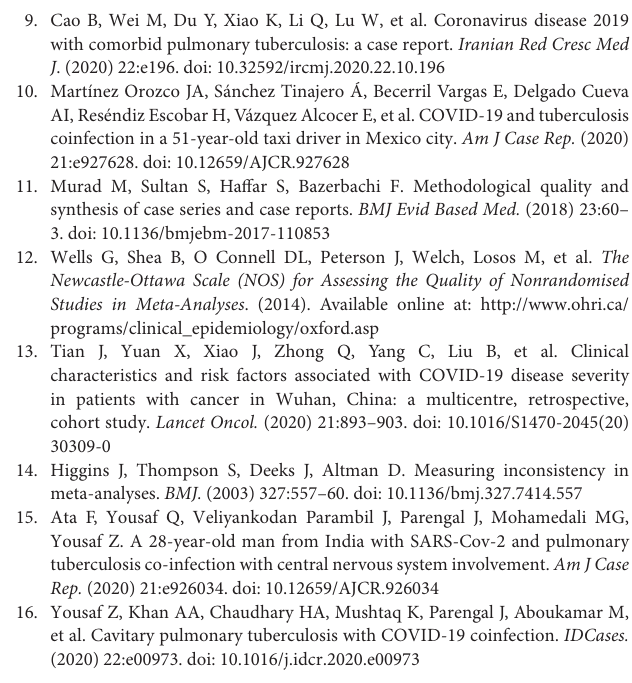
Table A1 | Search strategies for PubMed, Embase, Cochrane, CNKI, and Wanfang. CNKI, Chinese National Knowledge Infrastructure. Figure A1 | Funnel plot to detect publication bias. Figure A2 | Funnel plot to detect publication